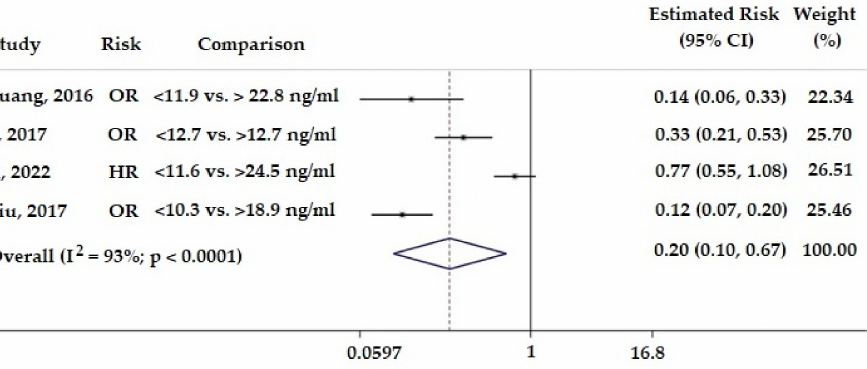
Figure 2. Forest plot of the predicting role of 25(OH)D levels on the risk of recurrent stroke [5,23–25]. Study: first author and year of the related study publication. Comparison: level of 25 hydroxy-vitamin D used for comparison. OR: Odds Ratio. HR: Hazard Ratio. 95% CI: 95% Confidence Intervals. The squares indicate the study-specific risk estimates. The square size quantifies the study-specific statistical weight; horizontal lines indicate 95% CI; diamond indicates the overall risk with its 95% CI. Weights are from random effects analysis.